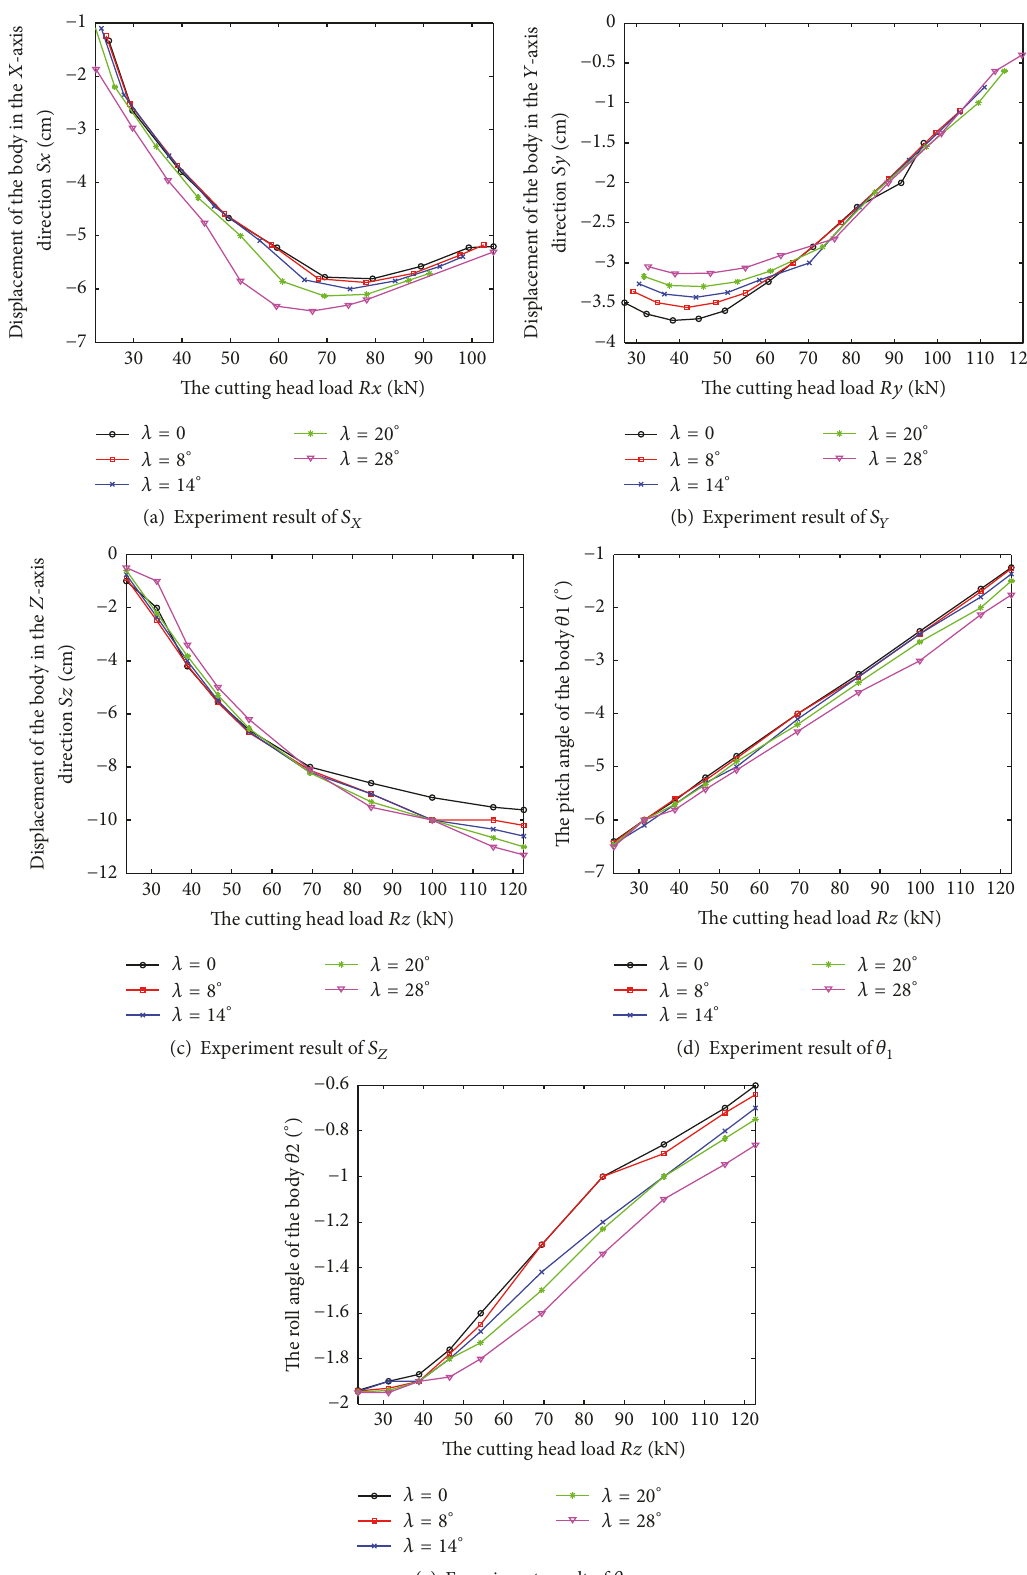
Figure 18: The experiment results of roadheader’s body